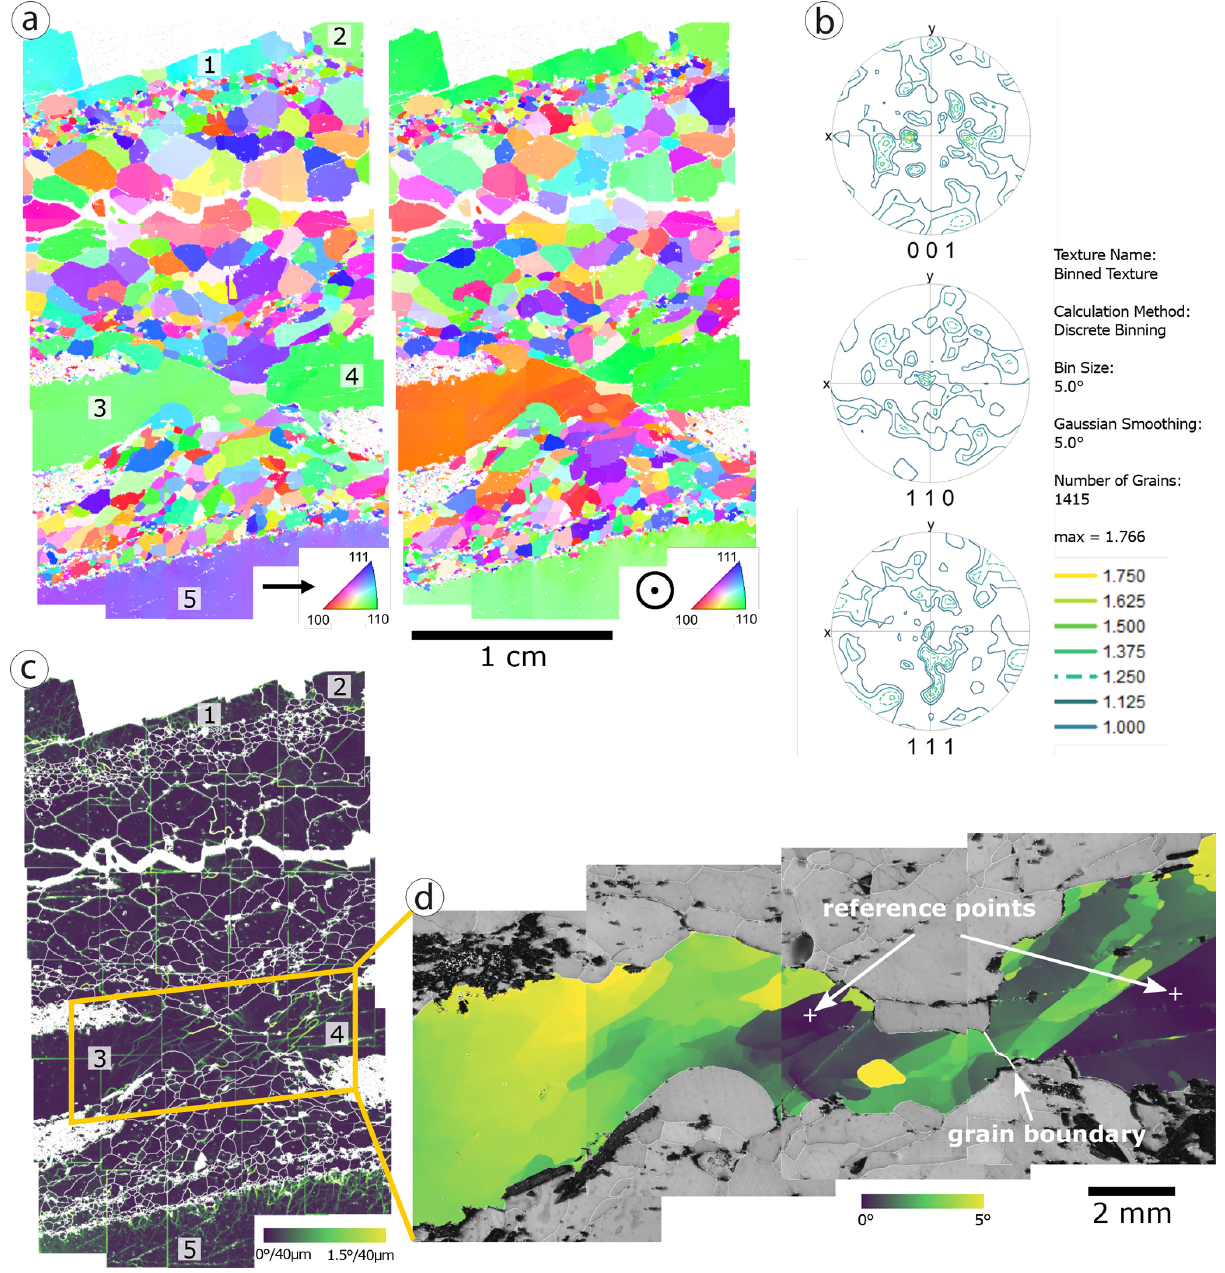
Figure 8. (a) Inverse pole figure maps for halite grains with large Kristallbrocken grains labelled 1–5. (b) Pole figures of fine-grained matrix halite excluding five Kristallbrocken grains show no significant crystallographic preferred orientation (CPO). (c) Kernel average misorientation (KAM) map overlaid with white low- and high-angle grain boundaries (misorientation > 5 ◦ ). KAM map was calculated over a distance of 40µm (second neighbour) with a threshold of 3 ◦ in order to enhance the small-angle subgrain boundaries. KAM shows subgrain-free matrix halite with few exceptions in large matrix halite grains, Kristallbrocken 1 and 5 with subgrains, and subgrains in boudin necks of Kristallbrocken 3 and 4. (d) Cumulative reference orientation deviation map over the areas of Kristallbrocken 3 and 4, based on more highly resolved EBSD measurements. Reference points for each of the two grains are indicated. Panels (a) and (b) consist of 30 individual measurements, which due to image distortion under 70 ◦ tilt cannot be stitched perfectly. Therefore, in some cases an artificial separation of areas belonging to the same grain is